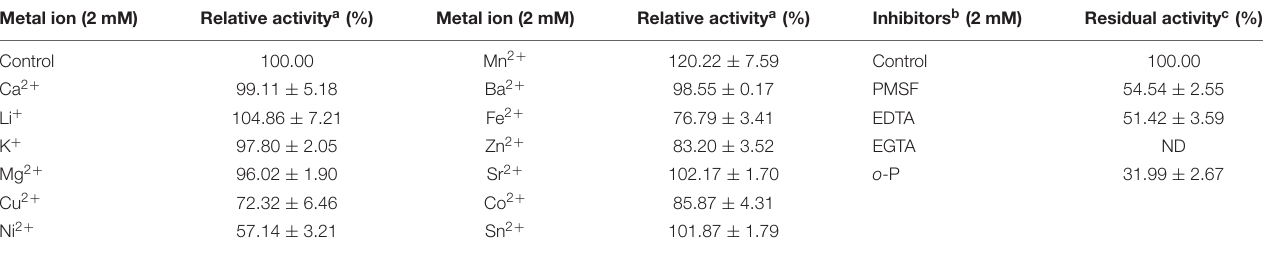
TABLE 2 | Effects of metal ions and inhibitors on activity of the protease of strain 1A02591. Metal ion (2 mM)